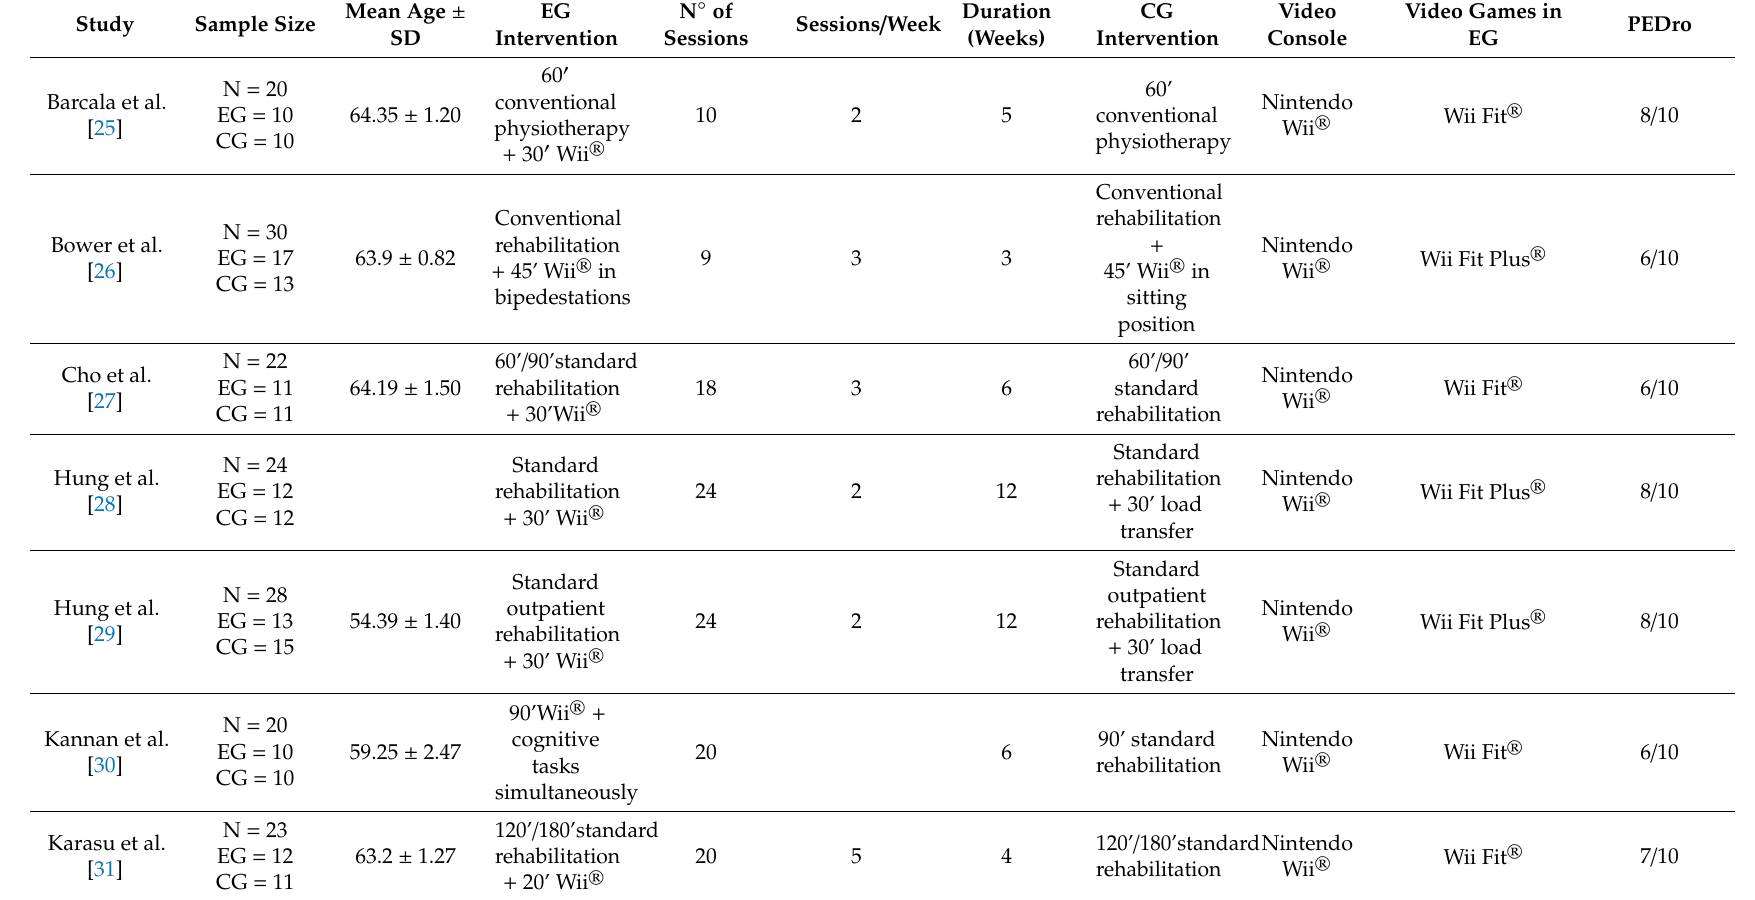
Table 3. Main characteristics of the studies included in the systematic review (SR) and